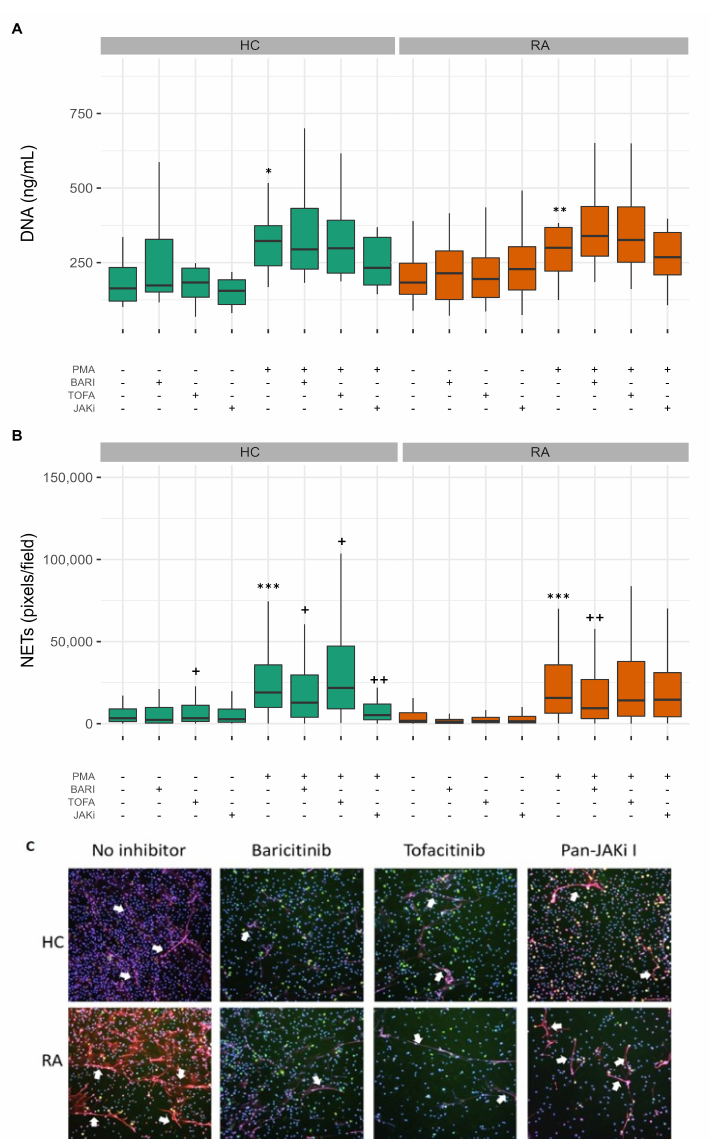
Figure 6. Effect of JAK inhibitors on NET production by HC and RA neutrophils. ( A ) PMA sig- nificantly increased the release of NET DNA into culture supernatants by HC and RA neutrophils (* p -value < 0.05, ** p < 0.01). This was not significantly affected by JAK inhibitors. ( B ) PMA sig- nificantly increased NET staining on coverslips (*** p < 0.001 compared to untreated). Baricitinib and pan-JAK inhibitor significantly decreased NET production by PMA treated neutrophils whereas tofacitinib increased NET production (+ p < 0.05, ++ p < 0.01). Machine learning was used to classify pixels as background, compact or NET. ( C ) Representative images for PMA-treated neutrophils are shown. Cells on cover slips were stained for DNA (DAPI, blue), myeloperoxidase (red) and elastase (green). White arrows indicate NET structures. (UNTR = Untreated, BARI = Baricitinib, TOFA = Tofacitinib, JAKi = Pan-Jak